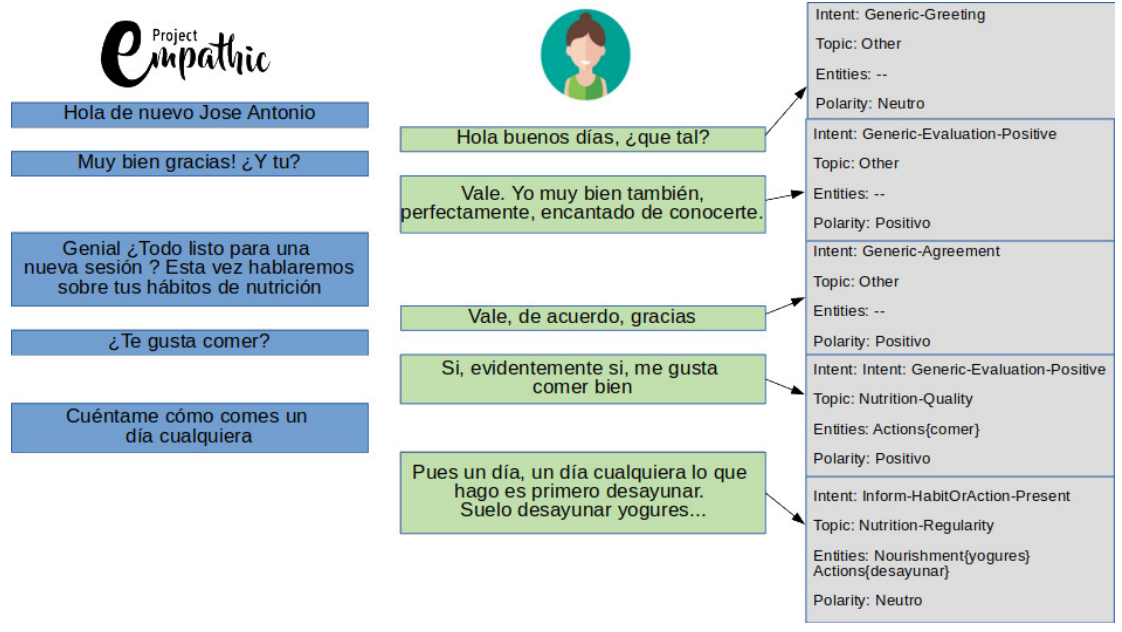
Figure A3. Spanish conversation